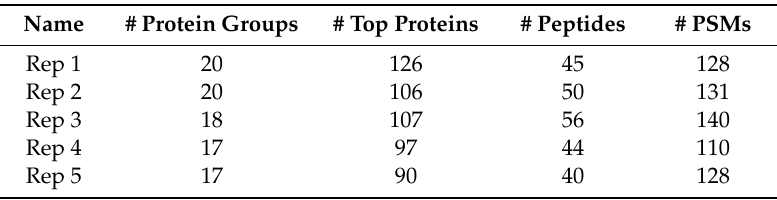
Table 3. Overview of the number (#) of protein identification groups, top proteins, peptides, and peptide-spectrum matches (PSMs) of five replicates of 1 ng of HeLa protein acquired with the sensitive method.